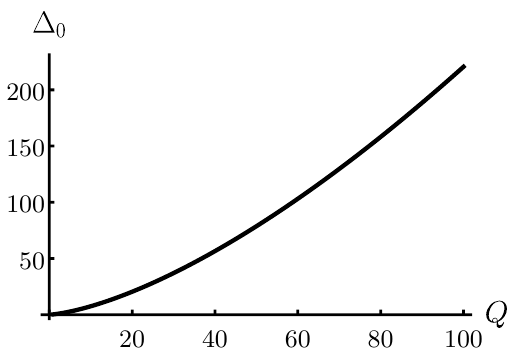
Figure 1. The O ( N 0 ) contribution to